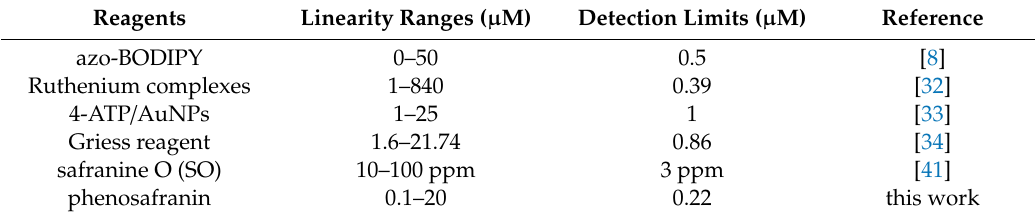
Table 1. Comparison of the analytical performance of previously reported colorimetric sensors with this work.